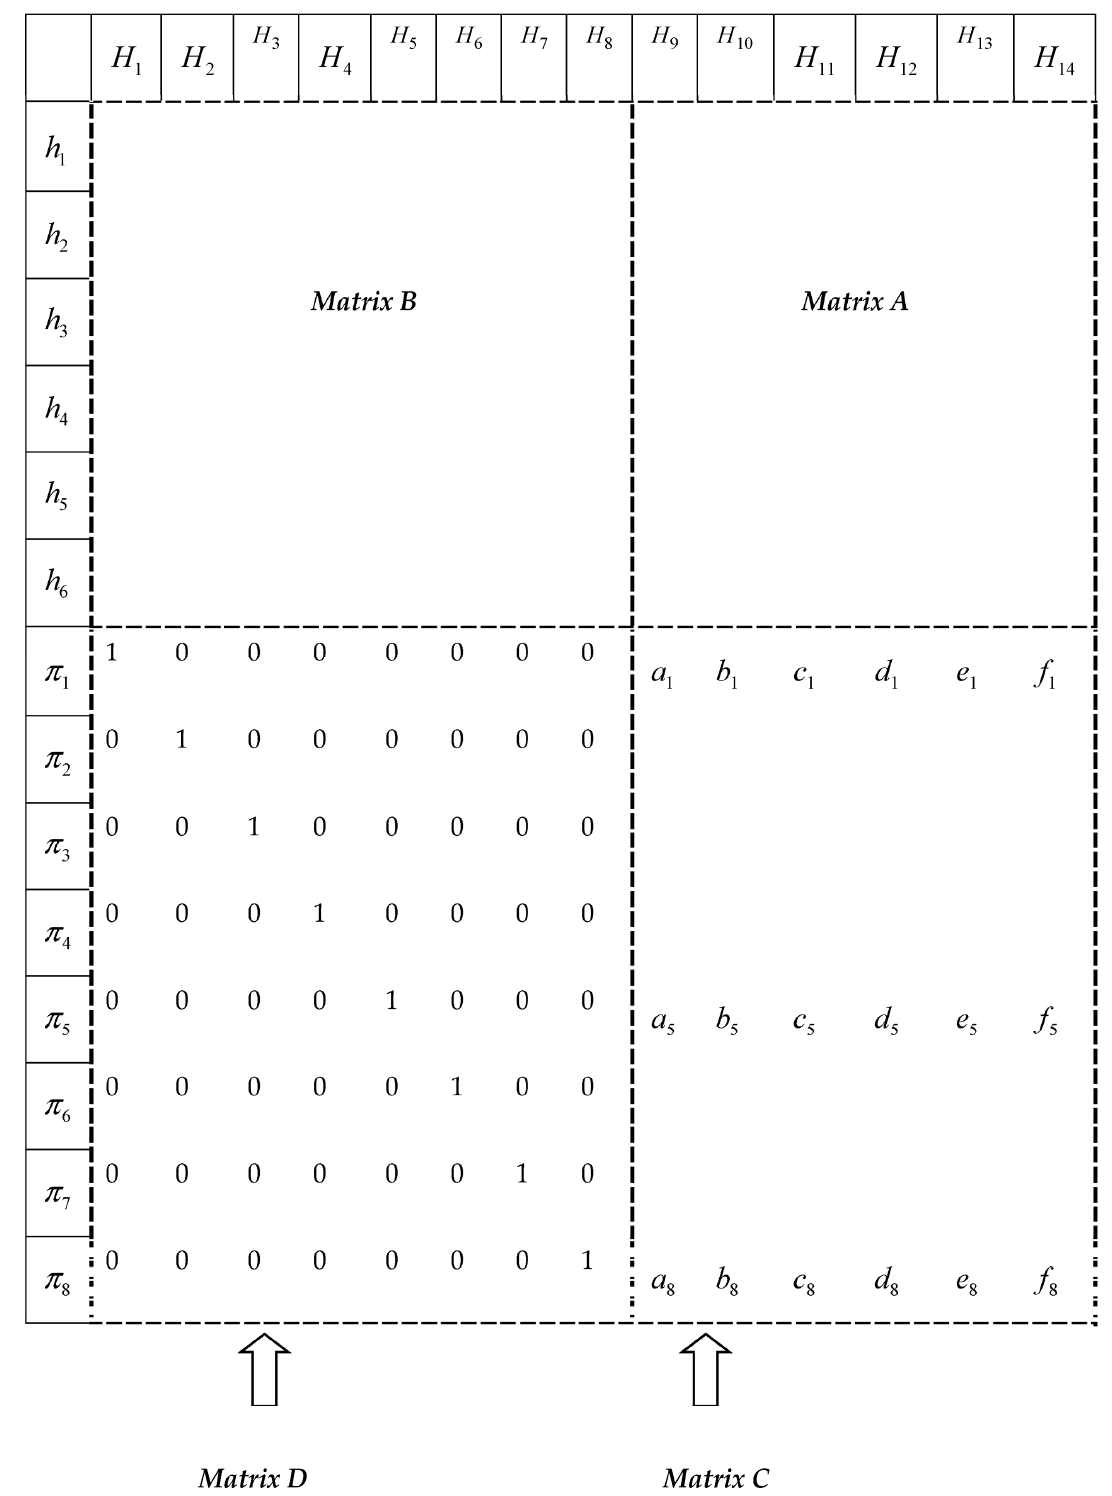
Figure 1. The illustration of how to obtain the elements of the model law. If considering, for example, the dimensionless variable π 5 , on its line there are the exponents of all involved independent variables ( H 9 , . . . , H 14 ), the exponents of the independent variables ( a 5 , . . . , f 5 ) , as well as the exponent of the dependent variable H , which is 1, being positioned on the main diagonal of matrix D . Consequently, 5 can be written as: